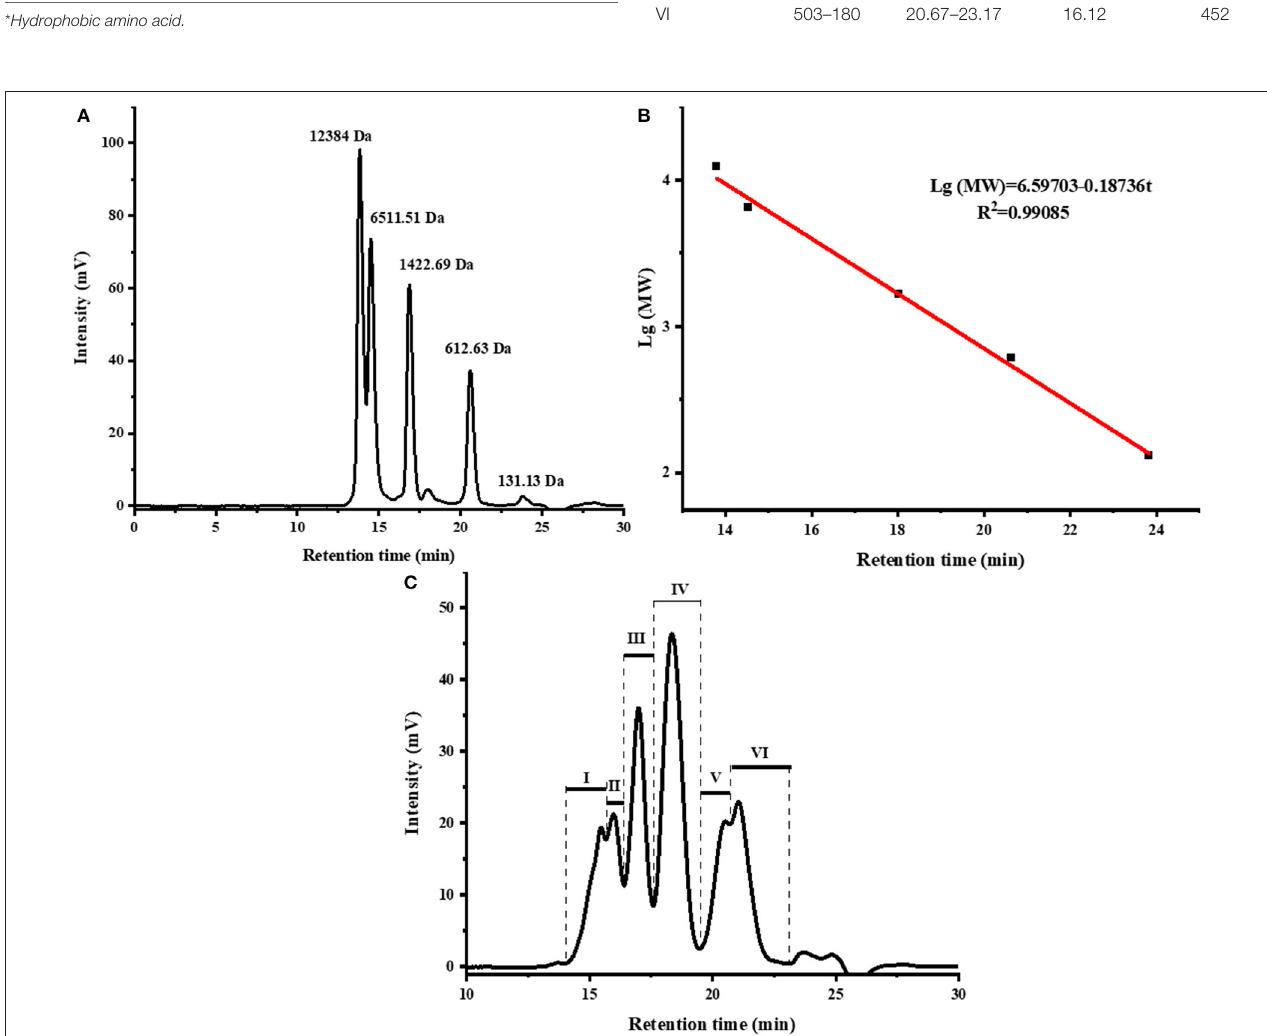
FIGURE 1 | The size exclusion chromatogram of standards (A) , molecular weight distribution curve of standards (B) , and the size exclusion chromatogram of fish scale gelatin hydrolysates, I, II, III, IV, V, VI represent the different components obtained (C) .